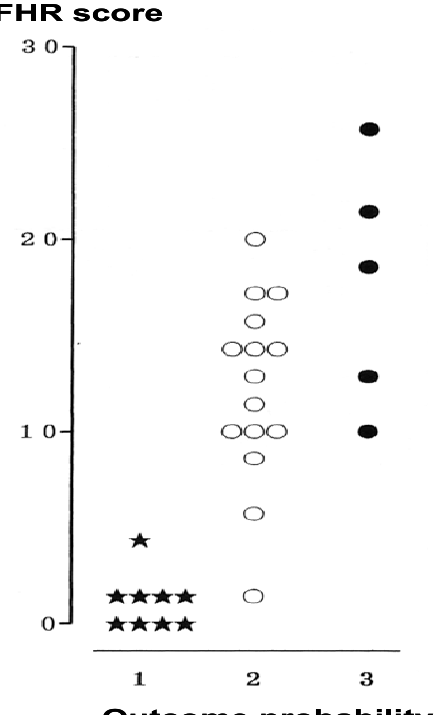
Figure 2. The relationship between outcome probability and FHR score [23]. The X-axis is the probability of normal (1), intermediate (2) and pathological outcome (3), and the Y- axis shows the FHR score. The probability of a pathological outcome (3) is distributed in the high FHR score area, the probability of an intermediate outcome (2) is distributed in the intermediate FHR score area, and the probability of a normal outcome (1) is distributed in the low FHR score area [14]. Thus, the NNW outcome probability strongly correlates with the FHR score revealing that the NNW diagnosis based on FHR monitoring is